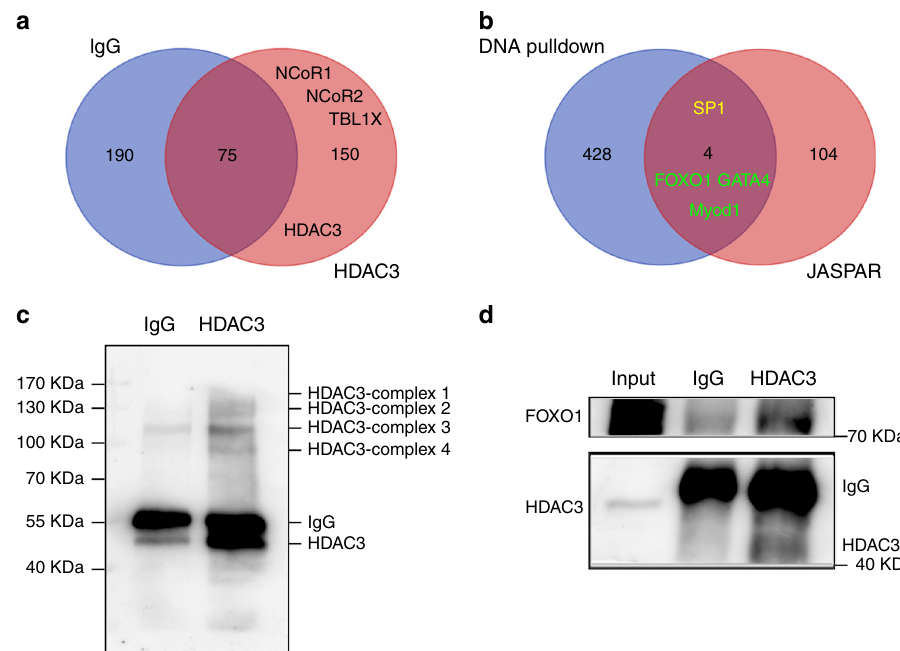
Fig. 4 FOXO1 potentially recruited HDAC3 to the Areg promoter. a Venn diagram of HDAC3 partners between the HDAC3-IP group and the negative IgG group revealed that HDAC3 could interact with the core members of the NCoR complex. b Venn diagram of potential transcription factors that bind the Areg promoter between the DNA pulldown data and JASPAR data. Among these transcription factors, FOXO1, GATA4, and Myod1 (green), but not SP1 (yellow), were identi fi ed as HDAC3 interactors. c Cross-linking Co-IP coupled with western blotting analysis of HDAC3 showed the captured HDAC3 complexes at the chromatin. n = 3 biologically independent experiments. d Reverse cross-linking Co-IP coupled with western blotting analysis of HDAC3 demonstrated the interaction between HDAC3 and FOXO1. n = 3 biologically independent experiments. Source data are provided as a Source Data fi